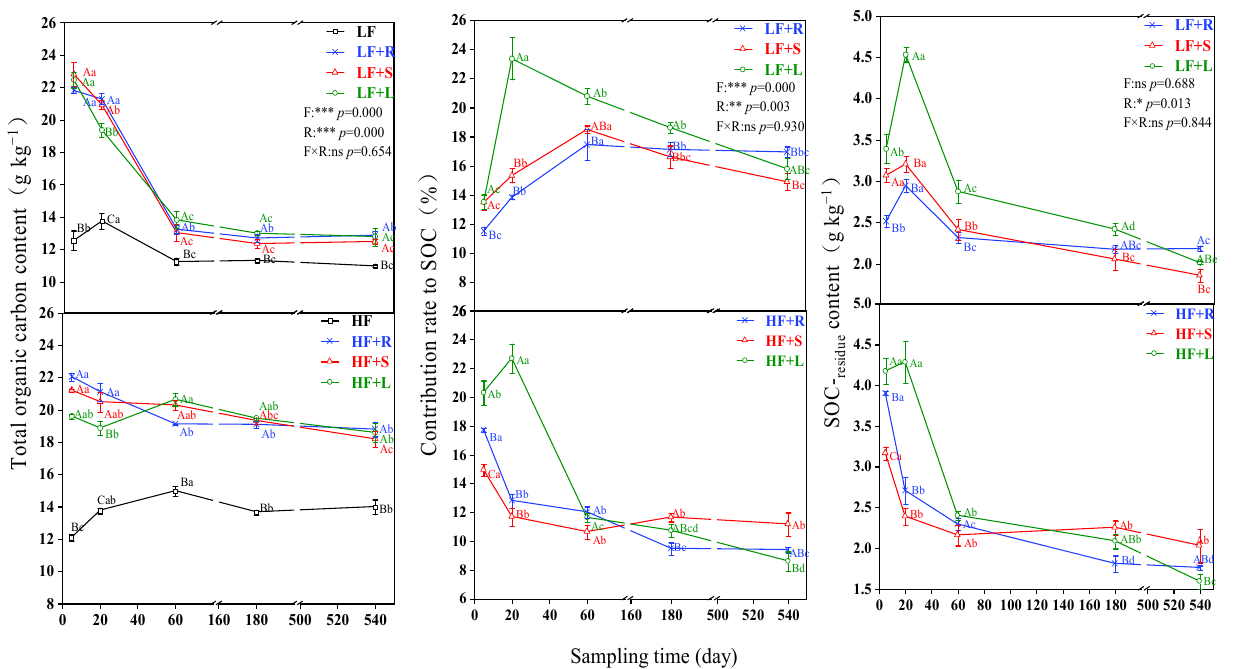
Figure 2. Distribution of different straw carbon in SOC in different fertility soils over 540 days. SOC-residue represents the carbon content derived from different residue types in SOC. LF and HF represent low- and high-fertility soil levels, respectively. R in blue, S in red and L in green represent the residues of the root, stem and leaf, respectively. Error bars represent the standard deviations from the mean (n = 3). F, R and F × R in black represent fertility level, residue type and the interaction of fertility level and residual type. *, **, *** and ns indicate significant difference at p < 0.05, 0.01 and 0.001, and no significance by ANOVA analysis, respectively. Different uppercase letters indicate significant differences between different treatments in the same sampling time, while different lowercase letters indicate signi fi cant di ff erences between di ff erent sampling times in the same treatment ( p < 0.05).